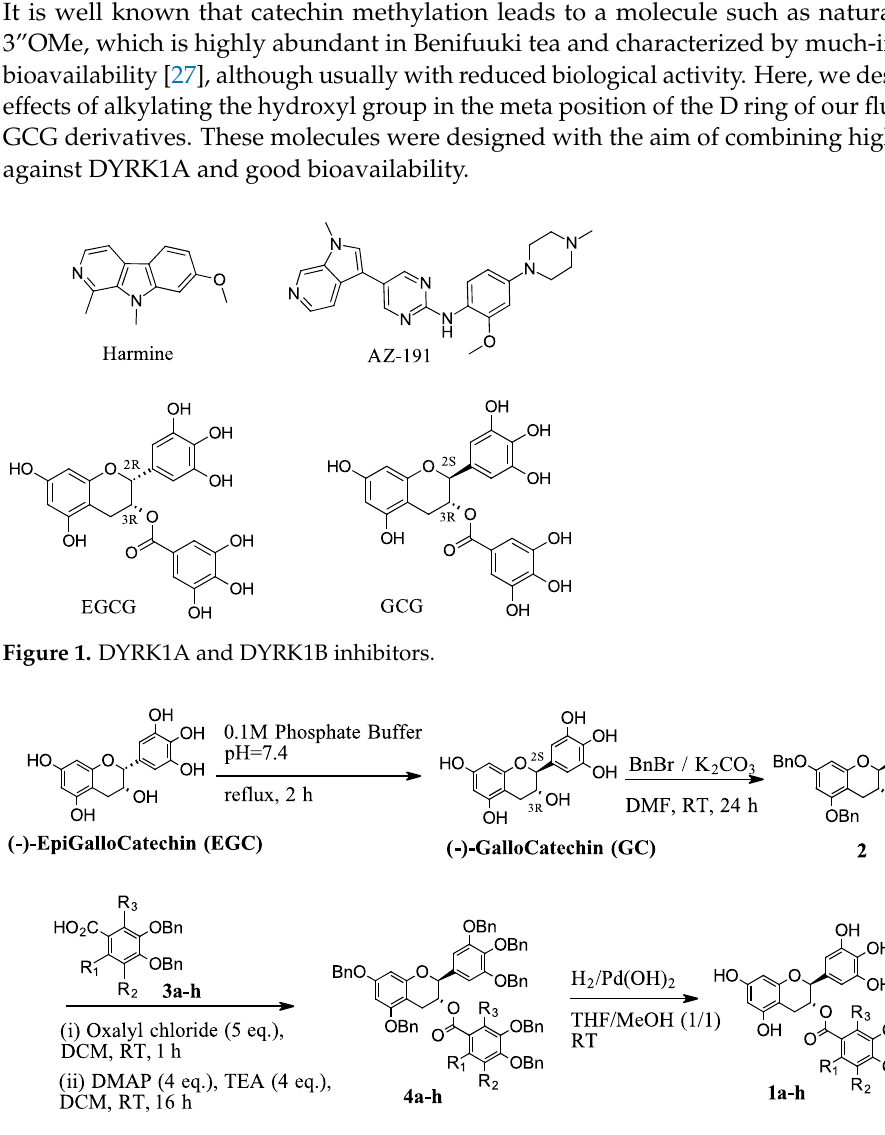
Scheme 1. Synthetic scheme for D-ring derivatives. Table 2. Summary of pharmacokinetic studies. Table 1. New D-ring derivatives. Compounds 1a–h (Scheme Table 1. New D-ring derivatives. Compounds 1a–h (Scheme 1).